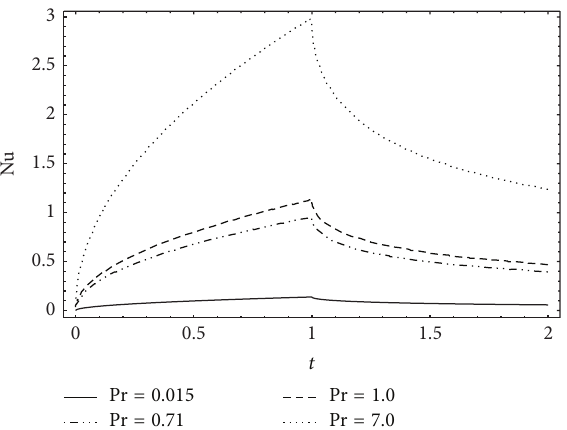
Figure 10: Variations of skin friction 𝜏 along 𝑡 for different values of 𝜂 corresponding to ramped temperature of the plate with Pr = 7.0 .